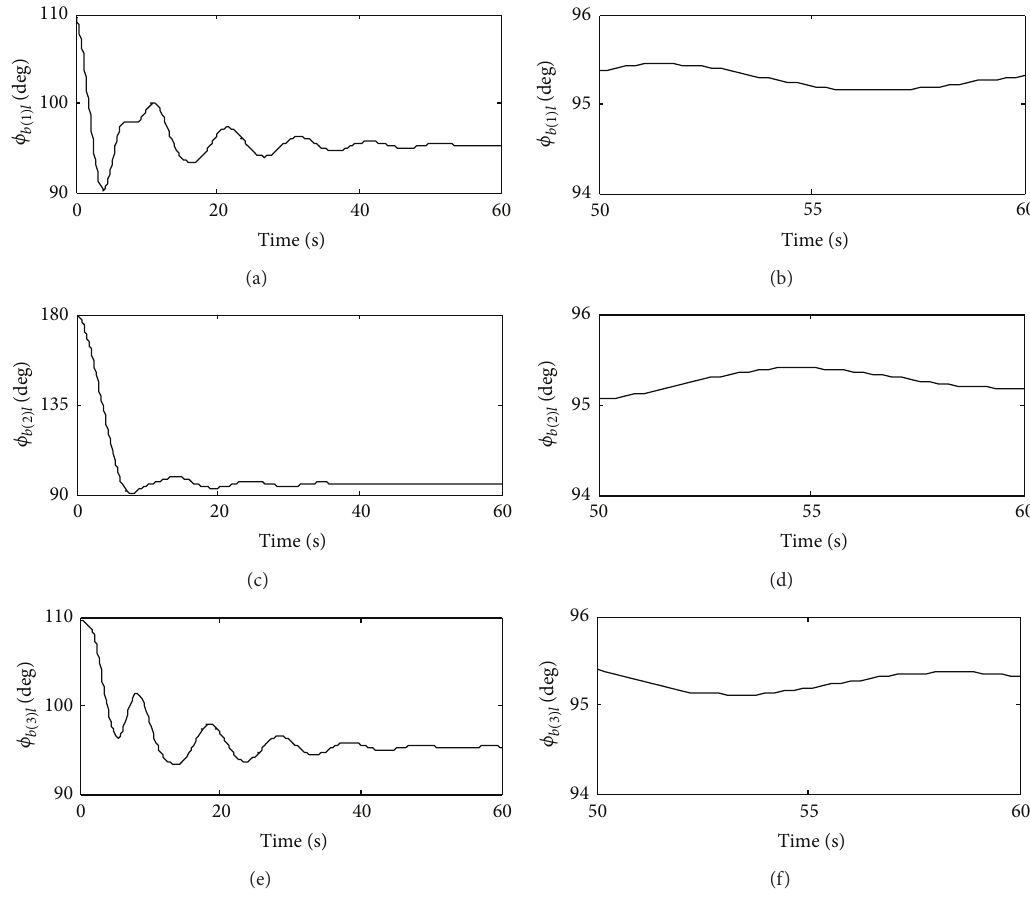
Figure 11: Absolute Euler angles; Theorem